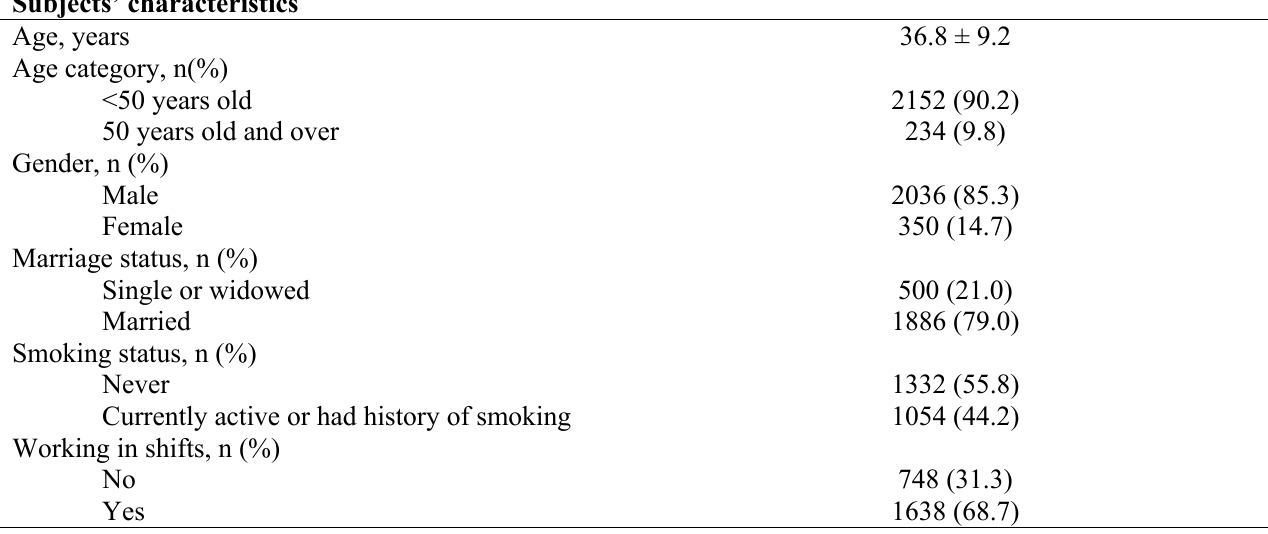
Table 1 . Subjects’ characteristics (n = 2386) Subjects’ characteristics